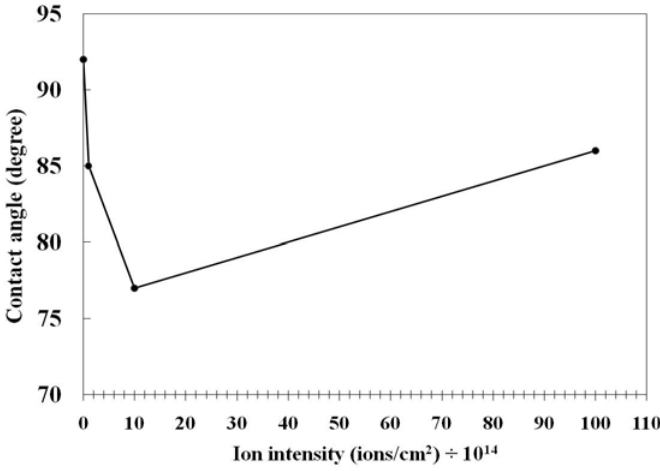
Figure 12. The effect of ion beam fluence on water contact angle values of the treated PVC (Reproduced with permission from [67]. Copyright 2010